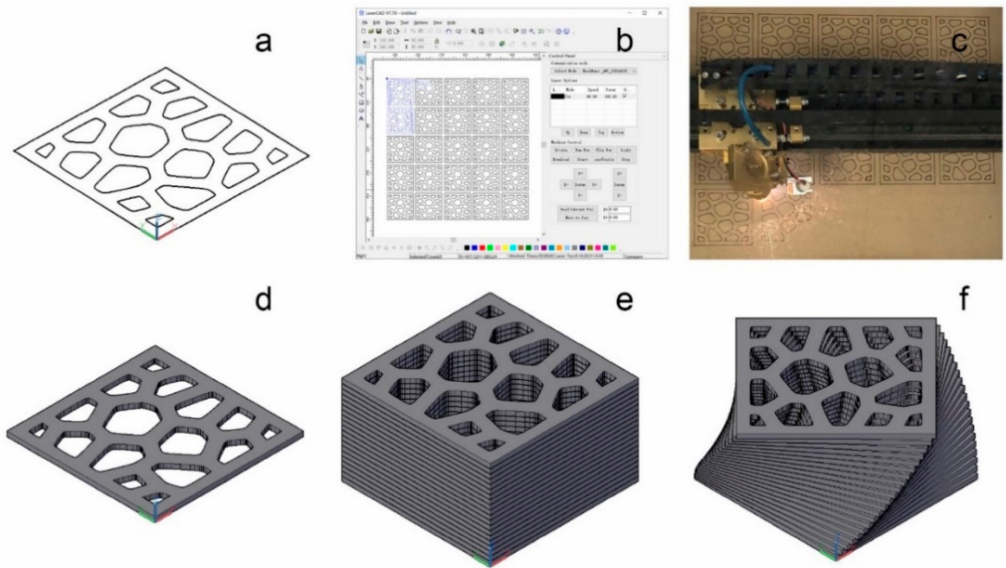
Figure 3. Model design methodology. ( a ) Outline of a Voronoi cellular-patterned cross-sectional layer; ( b ) Setting laser- processing parameters in the LaserCAD software, such as laser power, moving speed, etc.; ( c ) Laser-cut wood; ( d ) A layer slice after 1.5 mm of extrusion; ( e ) Stacking of layers along the Z-axis to create a layered model; ( f ) Layers are rotated to produce the model of the desired